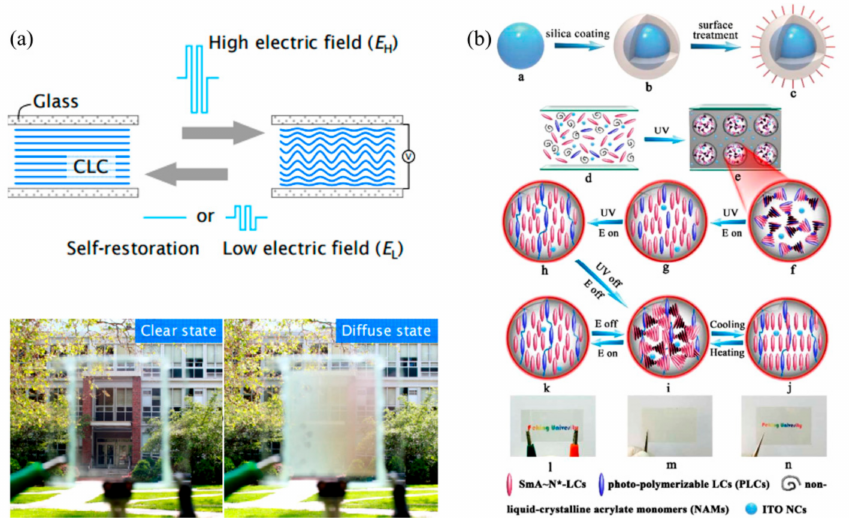
Figure 7. ( a ) Schematic diagram and photo of CLC smart window (d ≈ 45 µ m). Reproduced with permission from [58]. Copyright 2018, Optica. ( b ) Schematic diagram of preparation and response of ITOncs/liquid crystal. ( a – c ): a single ITO NC is encapsulated with a hydrophilic silicon barrier to form a core/shell structure, and then subjected to methacryloylpropyl-trimethoxysilane (MPTMS) surface treatment; ( d – k ): Preparation procedures for the smart film: a homogenous polymeric syrup is sandwiched between two plastic transparent substrates ( d ), and the film is irradiated with ultraviolet light to form a porous polymer network and LCs droplets ( e , f ). Then, an electric field is applied to perpendicularly orient the LCs ( g ), meantime, a second step of UV polymerization is carry out to complete the cross-linking between PLCs in the LCs droplets to form orientated liquid- crystalline polymer networks in the porous structure ( h ). According to temperature or electric field, the original film ( l ) can be reversibly changed between transparent ( n ) and opaque ( m ). Reproduced with permission from [60]. Copyright 2017, Royal Society of